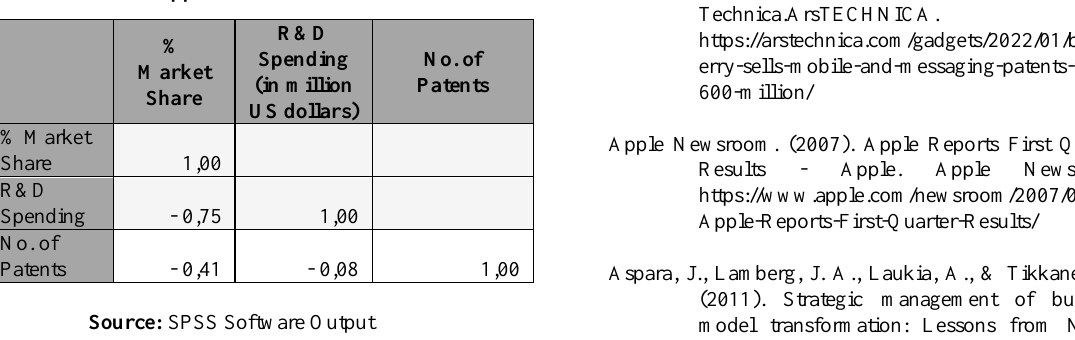
Table 14: Apple Correlations of